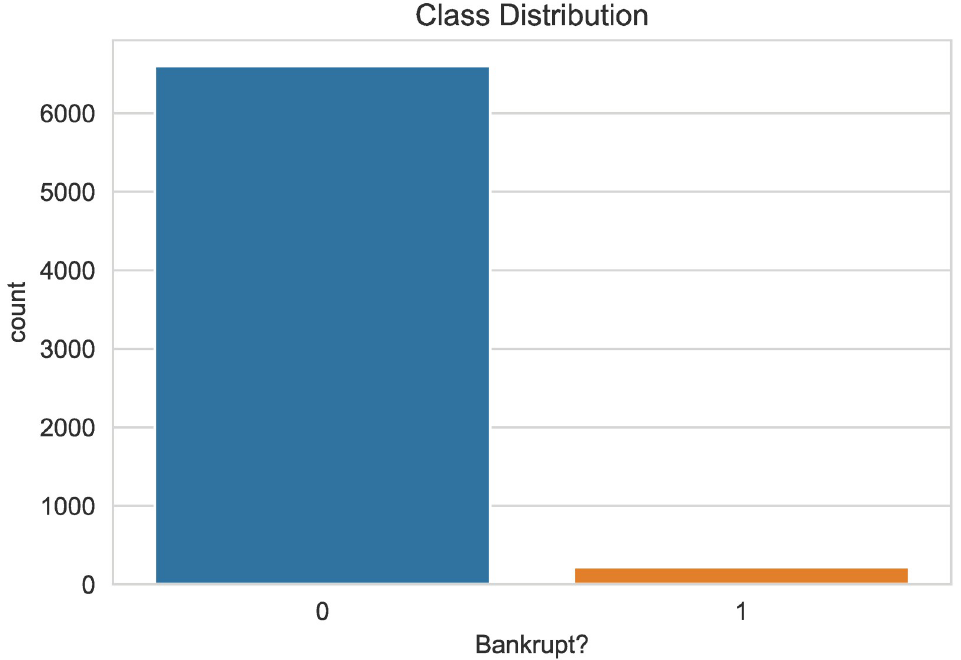
Fig 3. Class distributioin. As can be seen from the graph, there is a significant imbalance in the data, with 97% majority and 3.226% minority. https://doi.org/10.1371/journal.pone.0254030.g003 Table 1. Anomaly records.